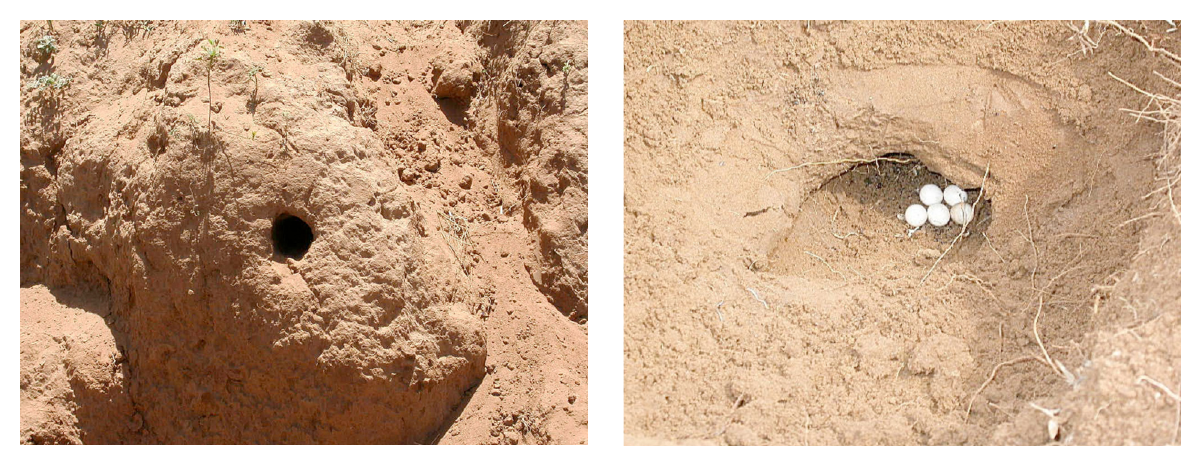
Table 1. Physical characteristics of Small Bee-eater nest holes and habitat around the nests (N = 34).